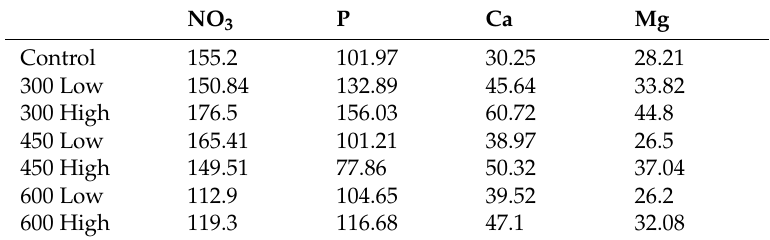
Figure 1. Growth index (cm 3 ) of ‘Micro-Tom’ plants at weeks 3 and 7 of all biochar treatments. Bars represent standard error (n ≈ 15). Different letters show significant difference ( p < 0.05) between treatments. Table 2. Mean concentrations (mg/L) of NO 3 , P, Ca, and Mg in leachates of plant growing media sampled at weeks 5, 8, and 10